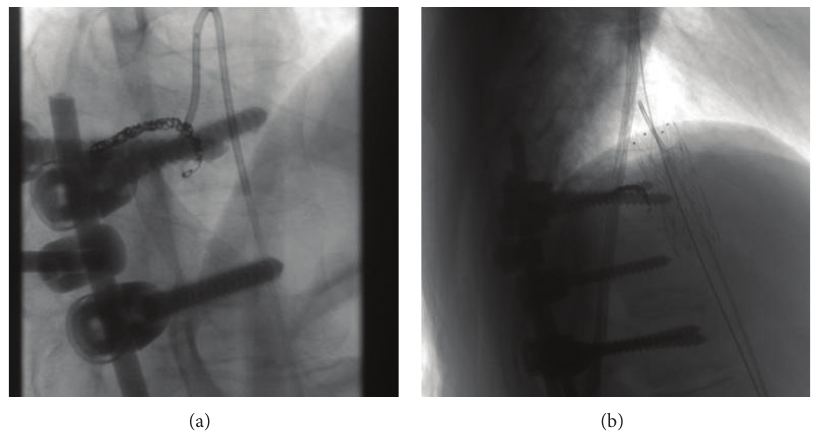
Figure 2: (a) Embolization of the T10 left intercostal artery with microcoils filling 3 cm of the vessel length, using the 4 fr Simmons catheter. (b) Placement of the stent graft by covering the site of penetration with the metal-free, central part of the